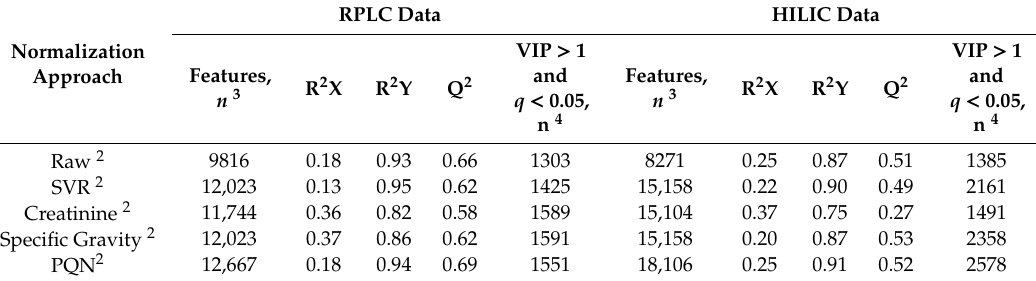
Table 3. Results of OPLS-DA analysis of variation associated with pre- and post-implantation status, and Wilcoxon paired signed-rank test of changes in peak area from pre- to post-implantation.